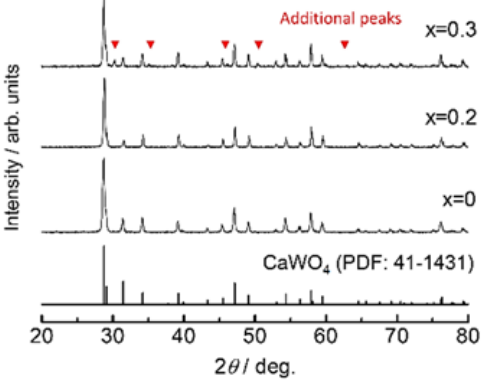
Figure 2. X ‐ ray diffraction patterns of Ca 1 − x K x WO 4 − x/2 obtained at room temperature.